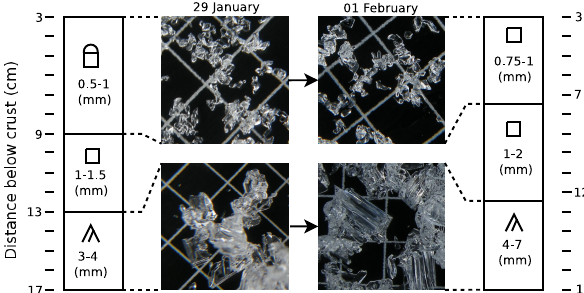
Fig. 5. Crystal changes subsequent to the gradients observed on 29 January 2011. The tops of the facet and depth hoar layers also grew closer to the crust, from 9 and 13cm below the crust, respec- tively, to 7.5 and 12.5cm below the crust. The grids on the crys- tal screen have 3mm spacing. Crystal types are from Fierz et al.